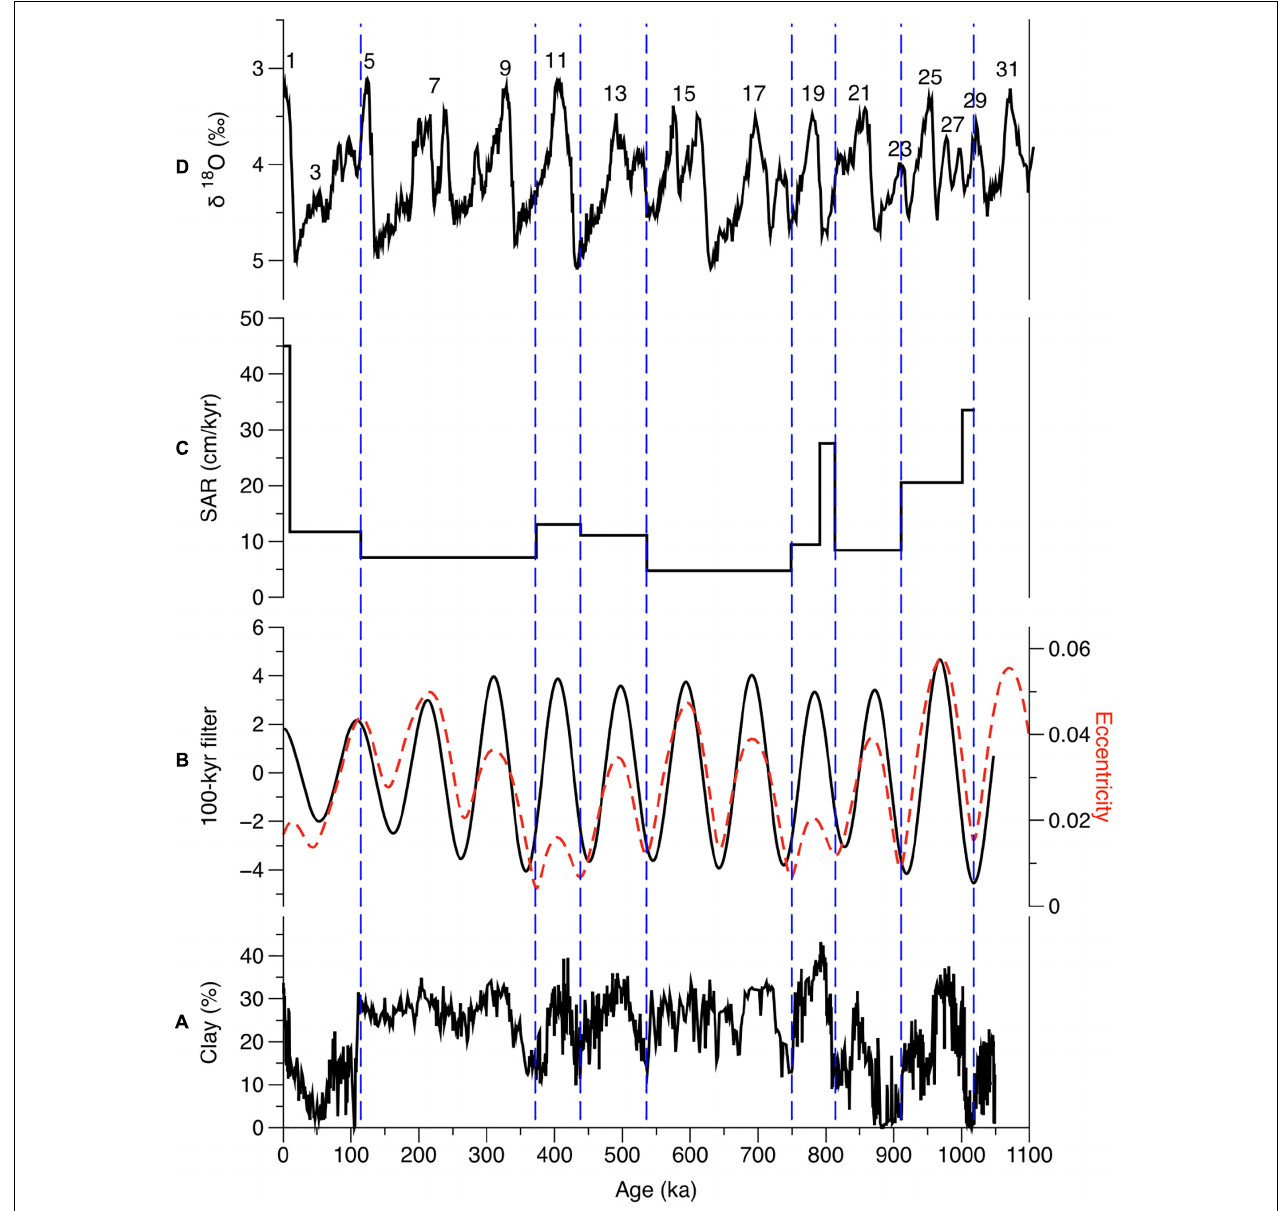
FIGURE 4 | Temporal variations in clay content (A) , filtered 100-kyr signal ( B ; solid lines) and associated theoretical orbital eccentricity (red dashed line; Laskar et al., 2004), sediment accumulation rate ( C ; SAR) and comparison with marine δ 18 O record ( D ; Lisiecki and Raymo, 2005) with Marine Isotope Stage (MIS) at interglacials labeled along the curve. Vertical dashed lines represent the newly added age points. Bandpass filters with central frequency of 0.01 and bandwidth of 0.002 were used to isolate the 100-kyr components of the clay fraction using AnalySeries software (Paillard et al.,